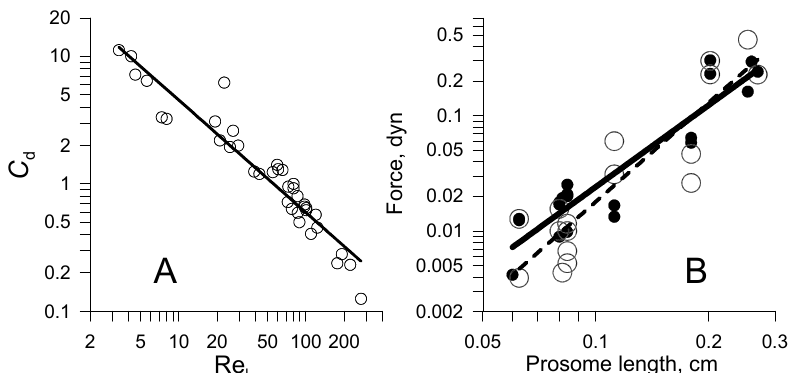
Figure 15. ( A ): Coefficient of hydrodynamic resistance C d,leg,att ( ○ ) from Equation (12) for cephalic limbs of 8 copepod species attached to a force sensor. ( B ): Propulsion force R p ( • ) calculated from experimental data for the same free cruise-swimming copepods based on C d,leg,att and, for comparison, the values of drag force R d ( ○ , dotted line) calculated by Equation (10).